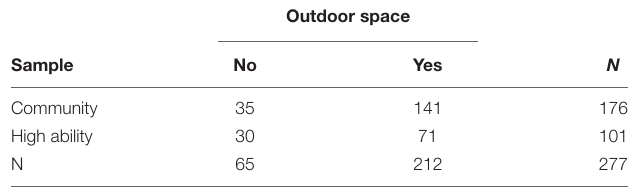
TABLE 6 | Outdoor space in the home for exercise.